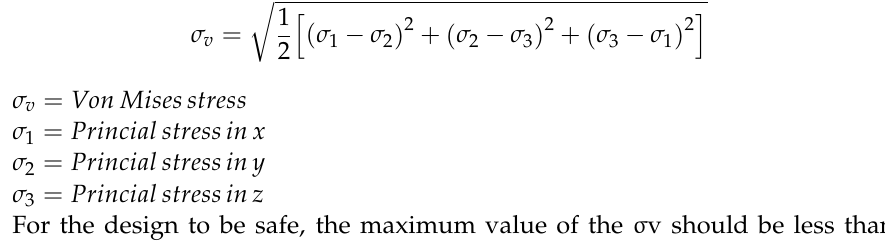
Figure 13. ( a ) Equivalent Von Mises stress for the bracket (MPa). ( b ) Total deformation (mm) for the bracket. The base of the brackets is taken as fixed support, and the forces are applied to the walls of the brackets.